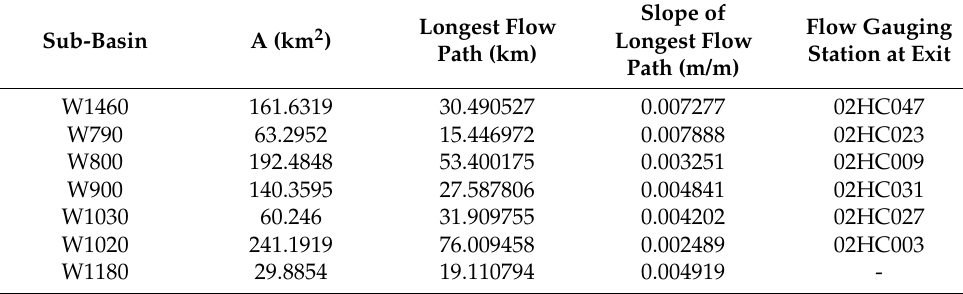
Table 1. Characteristics of the Humber